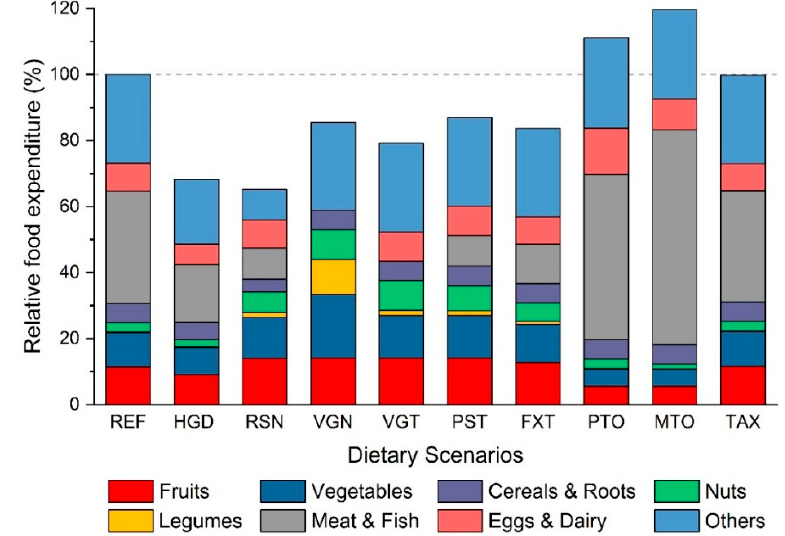
Figure 4. Cost of nine alternative diets relative to the current diet (REF = 100%). It can be seen that shifting from current to the meat oriented (MTO) and protein oriented (PTO) diets will increase the cost by 10–20% while adopting a diet based on global (HGD) or Swiss nutrition guidelines (RSN) will decrease the cost by ~35%. See Supplementary Table S6 for cost due to intake of individual food group.